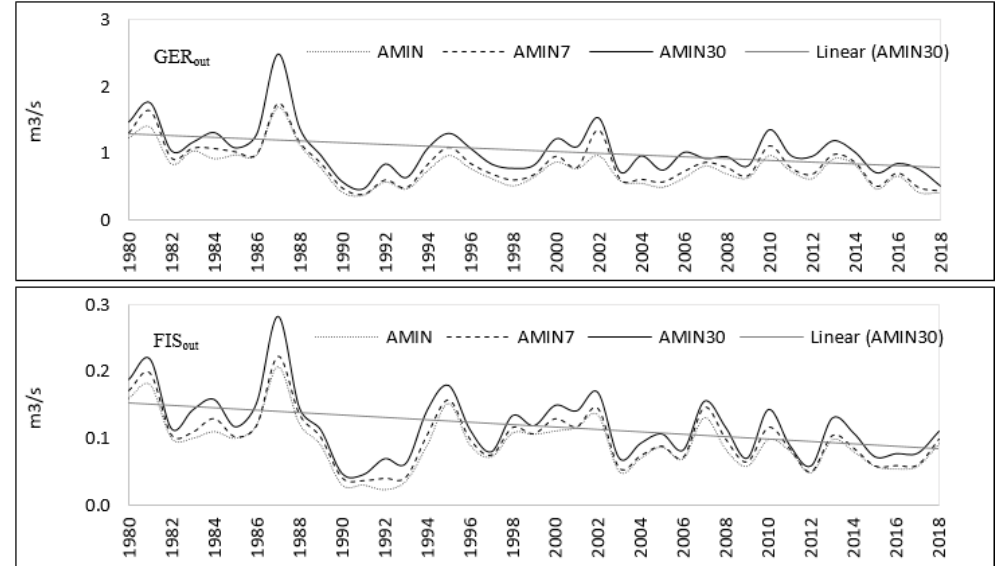
Figure 9. AMIN, AMIN7, and AMIN30 time series with linear trends given for the AMIN30 data in GER out and FIS out . Table 5. Top five years with the lowest extreme values (AMIN, AMIN7, and AMIN3) in GER out and FIS out .